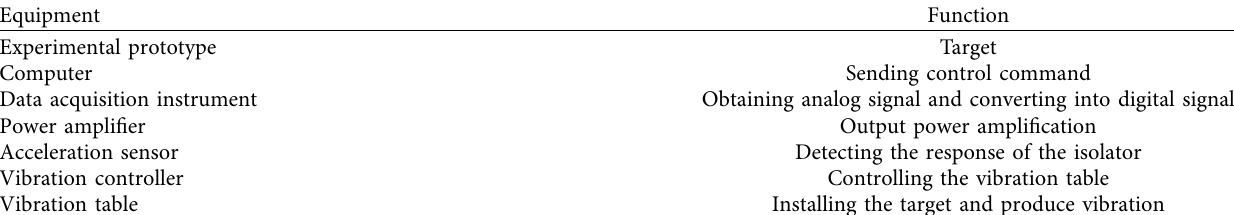
Table 2: Required equipment for the experiment.